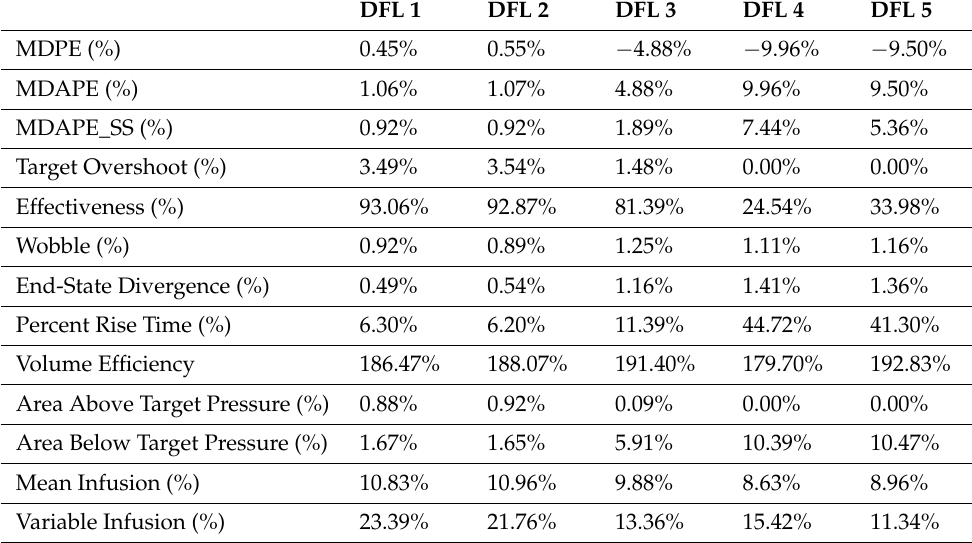
Table A3. Summary of performance metrics for Scenario 3. Performance metrics for each of five DFL controllers is shown as mean values for three subject variability runs.